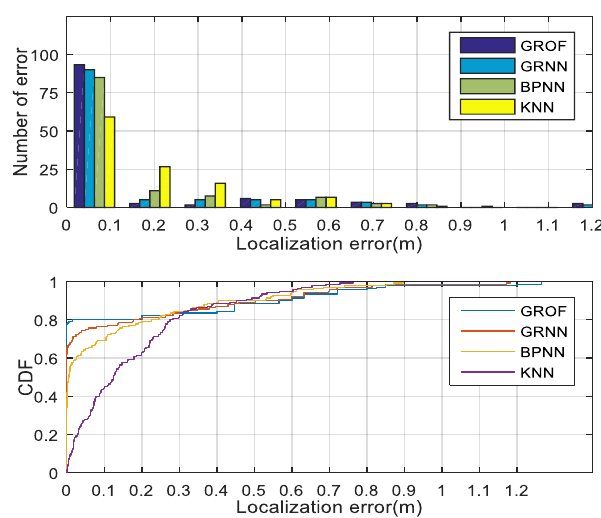
Figure 17. Localization error histogram and CDF of different algorithm in NLOS Case 1.